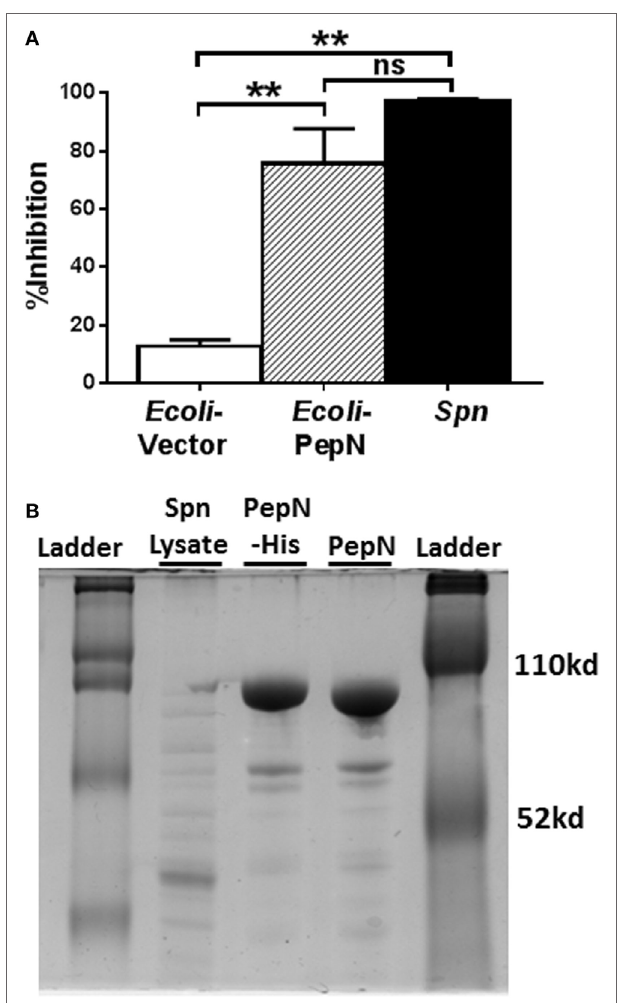
FigUre 5 | Lysate derived from aminopeptidase N (PepN)-His expressing Escherichia coli inhibits effector function. NP-specific cytotoxic T lymphocyte (CTL) was stimulated with peptide in the presence of 3 µg of lysate derived from E. coli transformed with either empty vector or the vector expressing PepN or with Streptococcus pneumoniae ( Spn ) lysate. (a) Percent inhibition of IFN γ production by Escherichia coli or Spn lysates (mean ± SEM). Data are from at least three independent experiments. A repeated measure ANOVA with a Tukey’s posttest was used to determine significance. ** p < 0.01. (b) Polyacrylamide gel depicting S pn lysate, column purified PepN-His and PepN with His tag